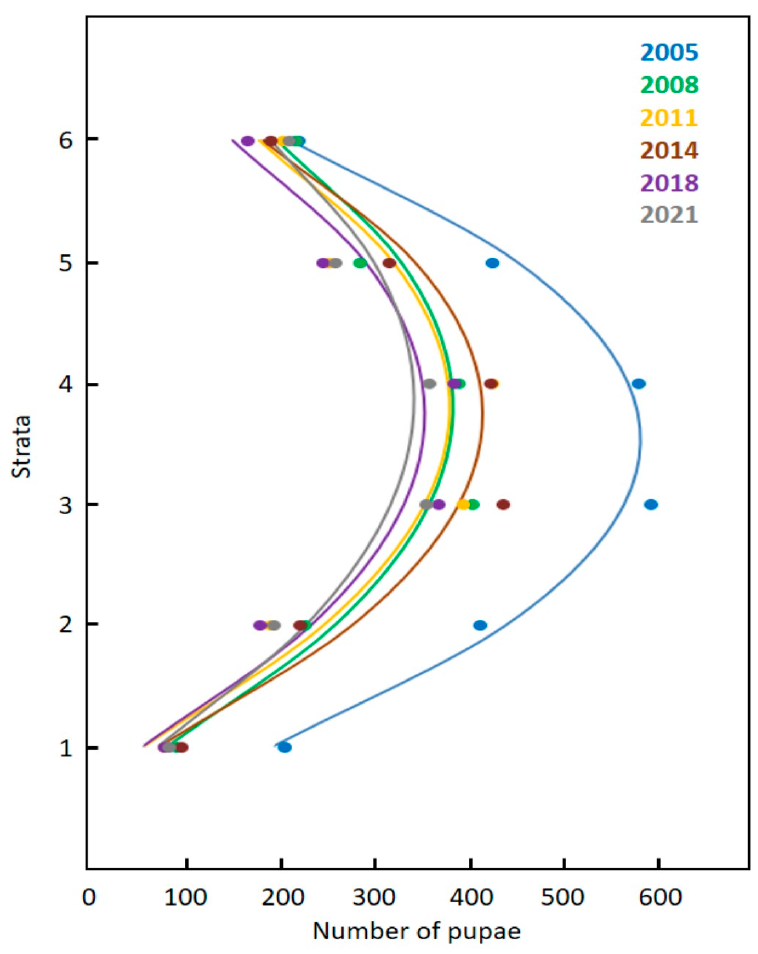
Figure 5. The influence of strata on the number of Anatrachyntis pupae in Cycas micronesica microstrobili in Guam karst. Forest from 2005 to 2021. Stratum 1 = basal stratum; strata 6 = apical stratum. 2005: pupae = − 173 + (427 × strata) − (61 × strata 2 ). r 2 = 0.96. 2008: pupae = − 171 + (291 × strata) − (38 × strata 2 ). r 2 = 0.92. 2011: pupae = − 215 + (313 × strata) − (41 × strata 2 ). r 2 = 0.85. 2014: pupae = − 221 + (339 × strata) − (45 × strata 2 ). r 2 = 0.92. 2018: pupae = − 201 + (296 × strata) − (40 × strata 2 ). r 2 = 0.88. 2021: pupae = − 150 + (254 × strata) − (33 × strata 2 ). r 2 = 0.90.